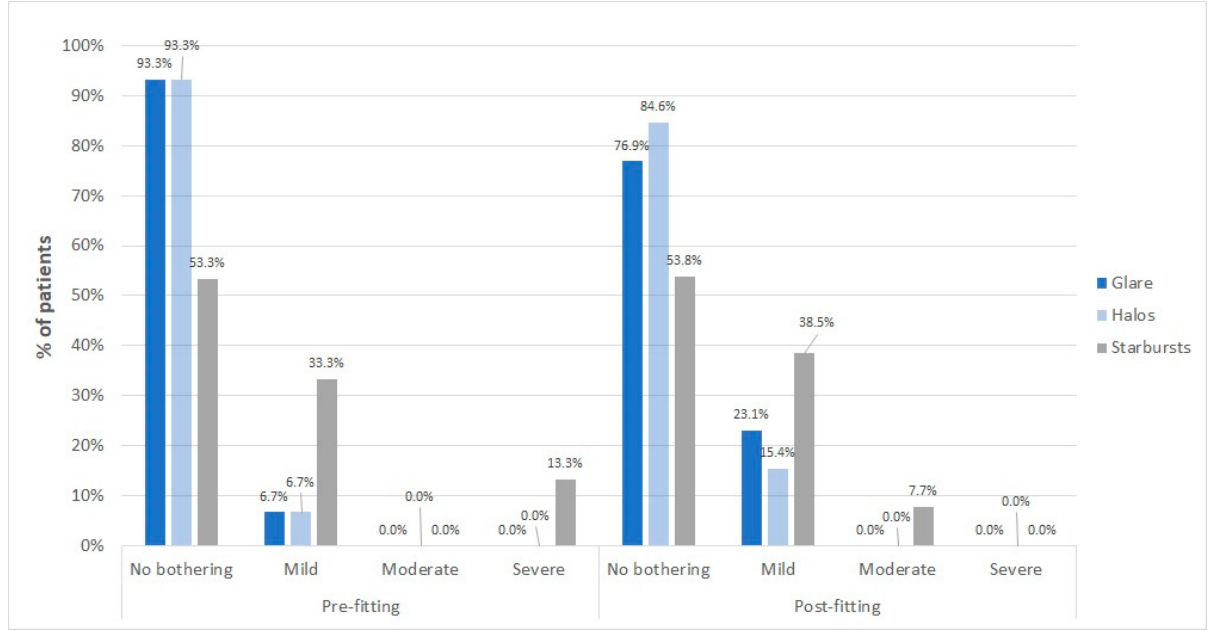
Figure 4. Distribution of the level of bothersomeness of glare, halos and starbursts perceived by patients before (with 15 patients) and after 30 days of CL wear (with 13 patients) in the sample evaluated.